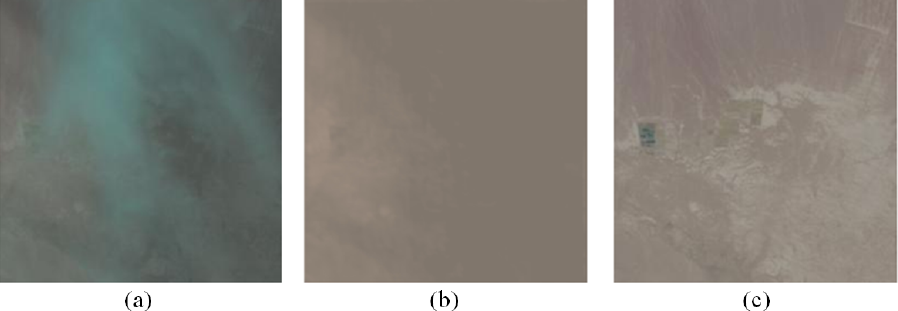
Figure 16. A failure case: smooth output for an image with overly heavy clouds: ( a ) input cloudy image, ( b ) reconstructed image by YUV-GAN, and ( c ) reference cloud-free